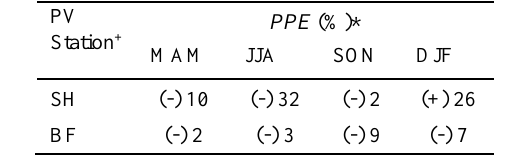
Table 3. Validation results for mean seasonal solar PV outputs.